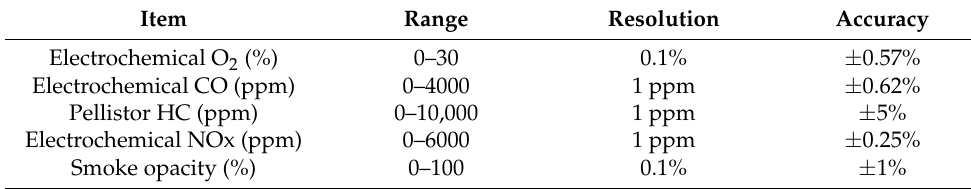
Table 4. Specifications of the exhaust emission